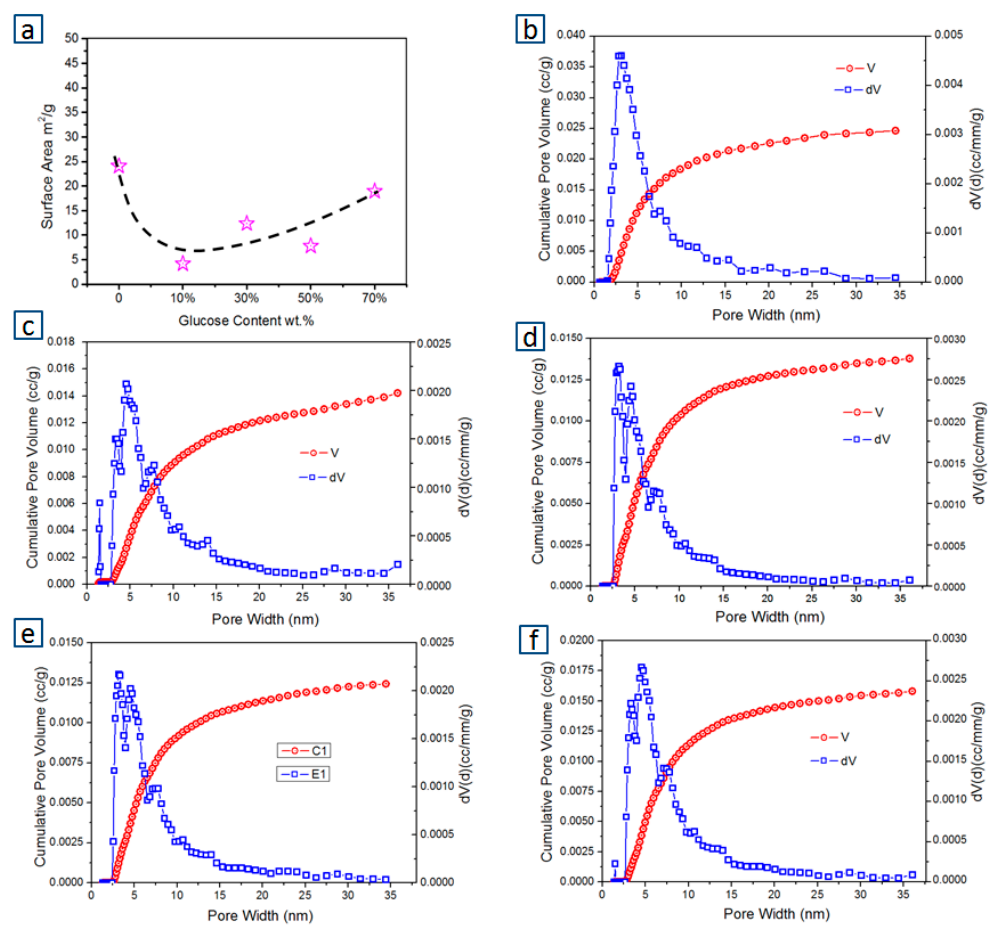
Figure 5. ( a ) Surface area in chars from different glucose: FB ratios; ( b ) pore size distribution (PSD) of char with no glucose; ( c ) PSD of char with 10% glucose; ( d ) PSD of char with 30% glucose; ( e ) PSD of char with 50% glucose; ( f ) PSD of char with 70% glucose.